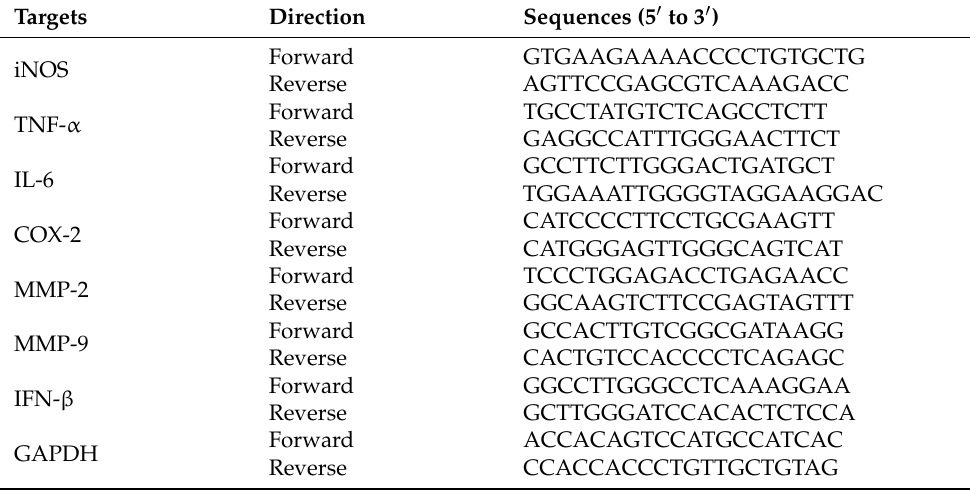
Table 2. Primers used in this study (mouse species).